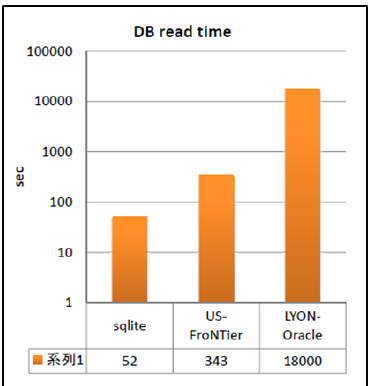
Figure 2. A graphical representation of the database access times observed from event process- ing tasks on local Tokyo worker nodes to three database sources: a local SQLite file, a Frontier de- ployment in New York (USA), and direct database access in Lyon ( France). Data access was over 50 times faster via Frontier than direct Oracle access over a